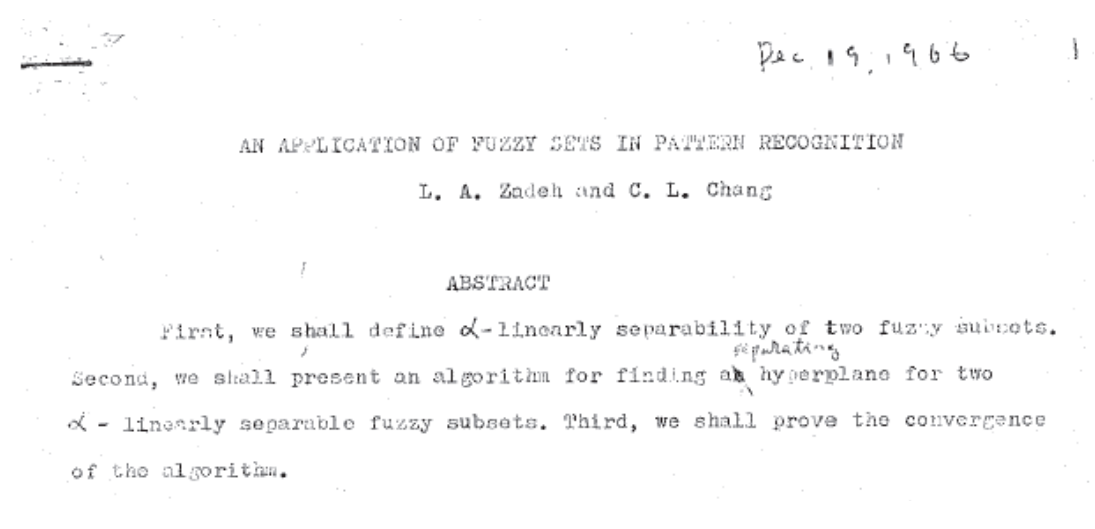
Figure 10. Unpublished manuscript (excerpt) of Zadeh and Chang, 1966. (Fuzzy Archive, Rudolf Seising). Rosenblatt heralded the perceptron as a universal machine in his publications, e.g., “For